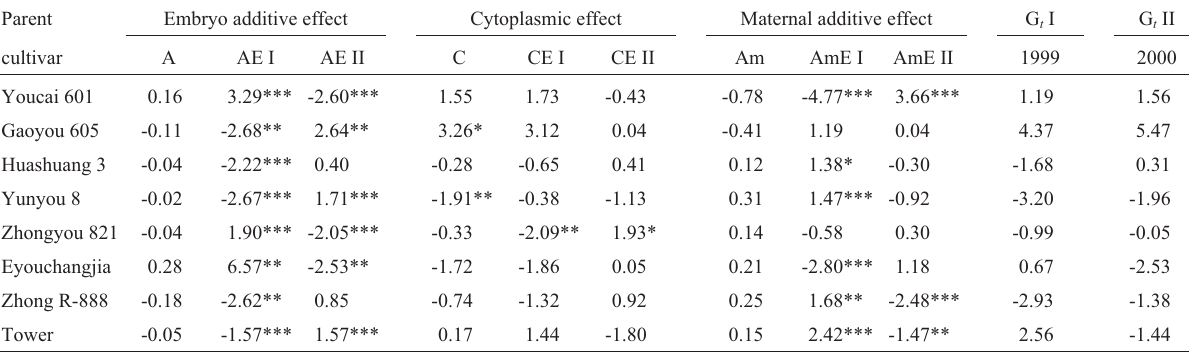
Table 1 - Predication of genetic main effects and GE interaction effects for oil content (%) of rape seeds.